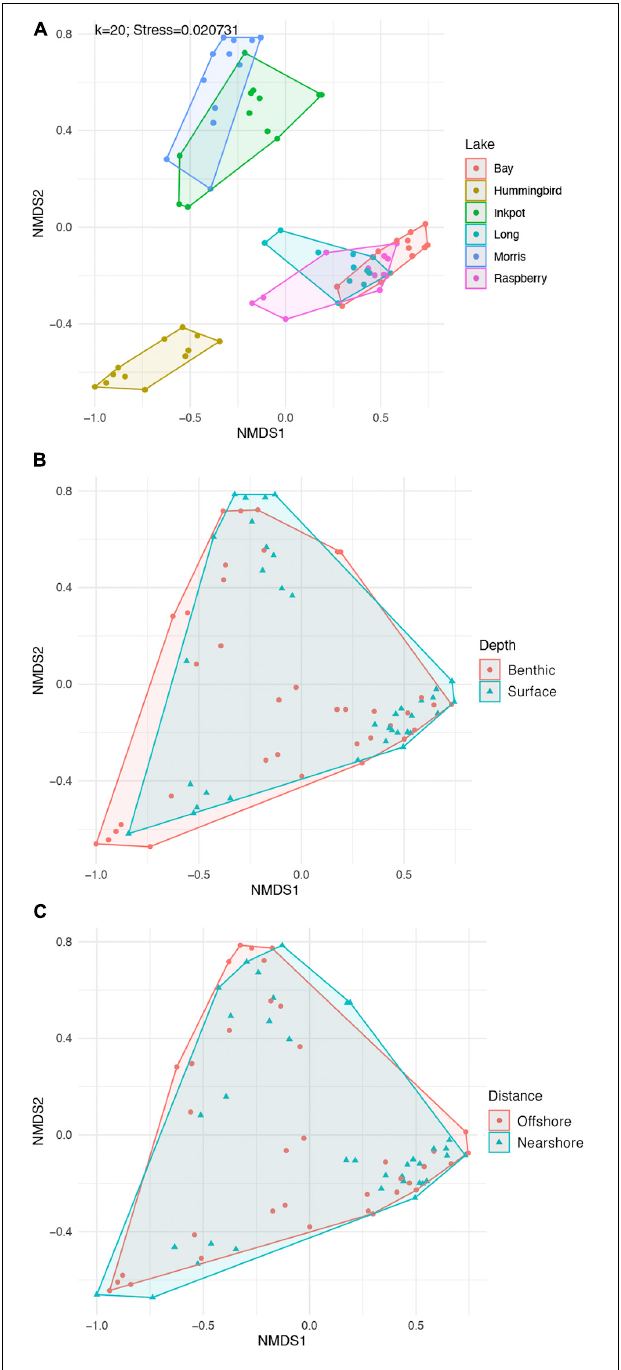
FIGURE 7 | Visualizations of diversity among lake communities based on 12 spatially varied eDNA samples from each of six lakes. Each point represents the read-abundance-based community of one sample from the indicated lake. All plots are based on NMDS ordination of Bray-Curtis distances calculated from log + 1-transformed read abundances. (A) Diversity among the six lakes, showing substantial clustering of points within lakes, corresponding to the R 2 -value of 0.5109 ( Table 3 ). The bottom two plots are the same points grouped (B) by depth category and (C) by shore distance category, showing the substantial overlap between the 36 sampling locations in one category vs. the